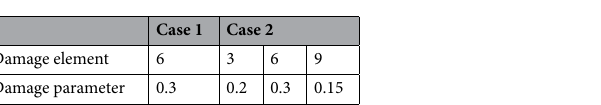
Table 2. Two local damage